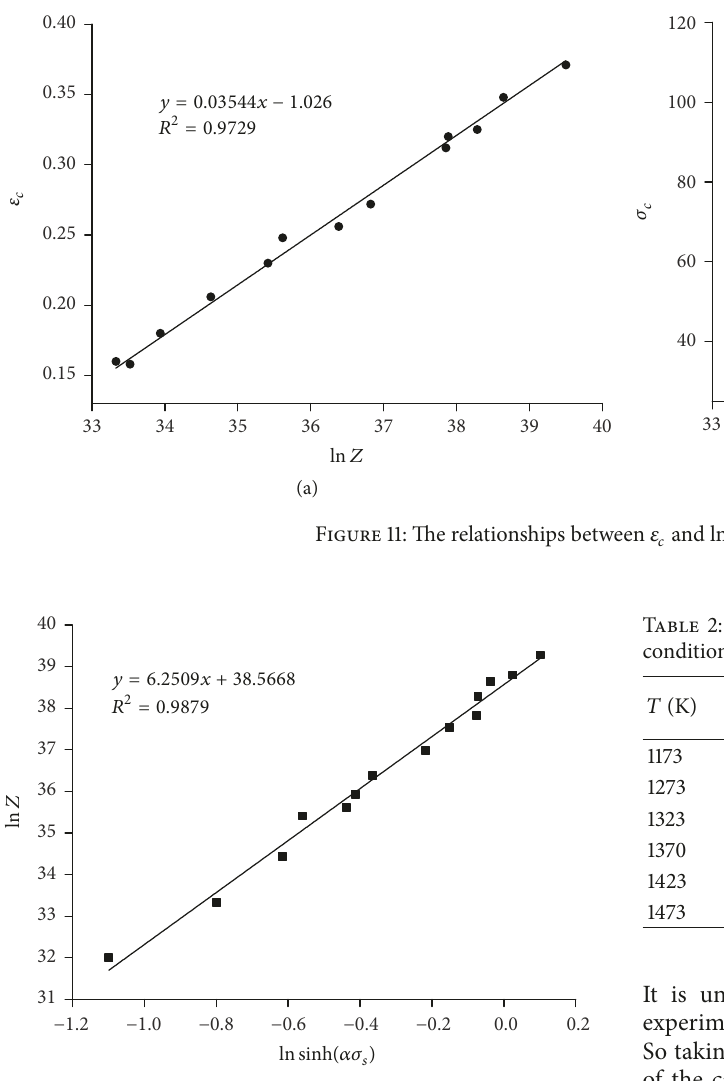
Figure 12: Relationship between ln 𝑍 and ln [ sinh (𝛼𝜎 𝑠 )] .